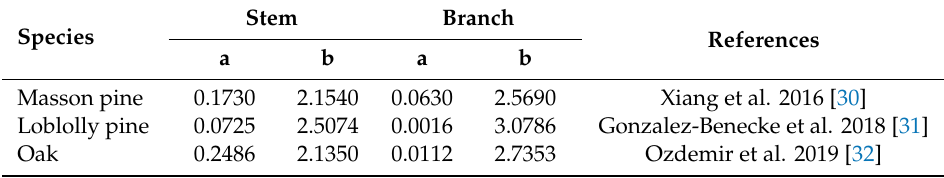
Table 1. Parameters in allometric biomass equation for the three tree